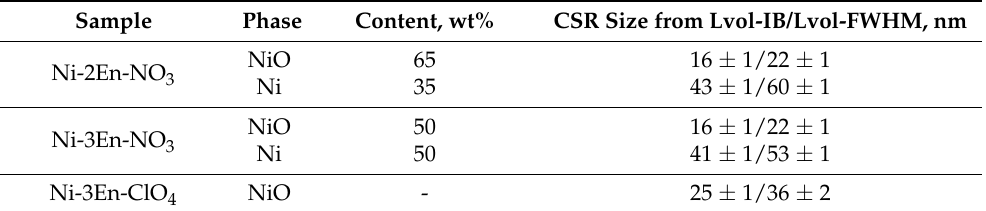
Table 4. The analysis of XRD data for the Ni-2En-NO 3 , Ni-3En-NO 3 and Ni-3En-ClO 4